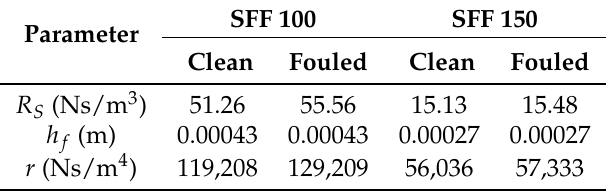
Table 2. Specific flow resistance, thickness and flow resistivity of clean and fouled SFF 100 and SFF